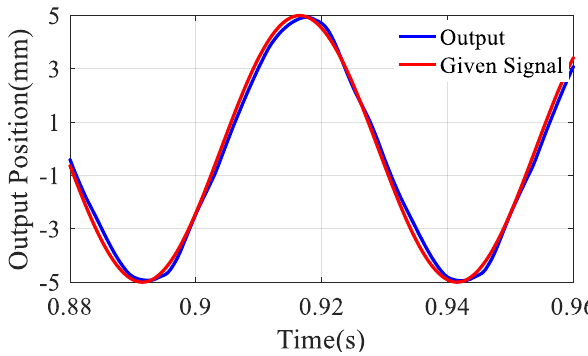
Figure 19. Output position with 800 N amplitude of rectangular force.